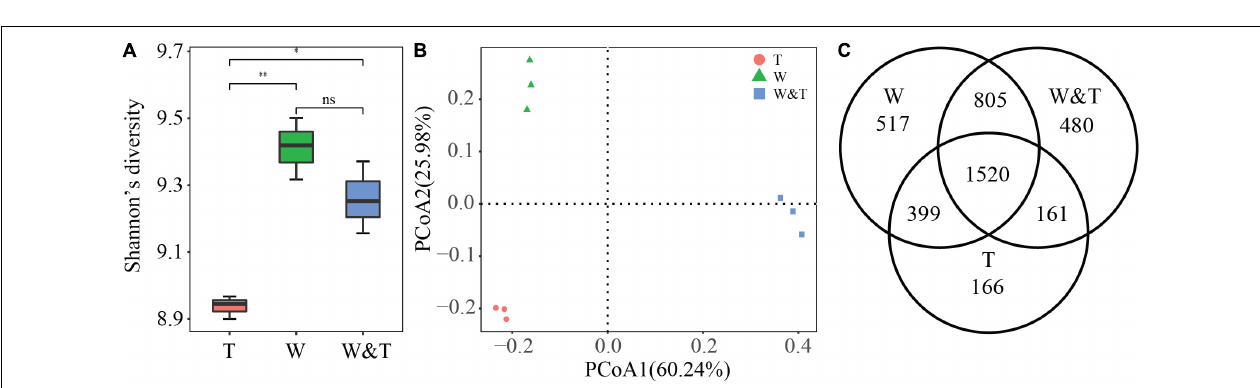
FIGURE 2 | Chemical properties (A) and enzyme activities (B) of the pure forest and intercropping forest. A different lowercase letter on each bar indicates a least significant difference (LSD; p < 0.05) between monoculture tea forest (T), monoculture walnut forest (W), and walnut–tea intercropping forest (W&T). AN, available nitrogen; AP, available phosphorus; AK, available potassium; OM, organic matter.